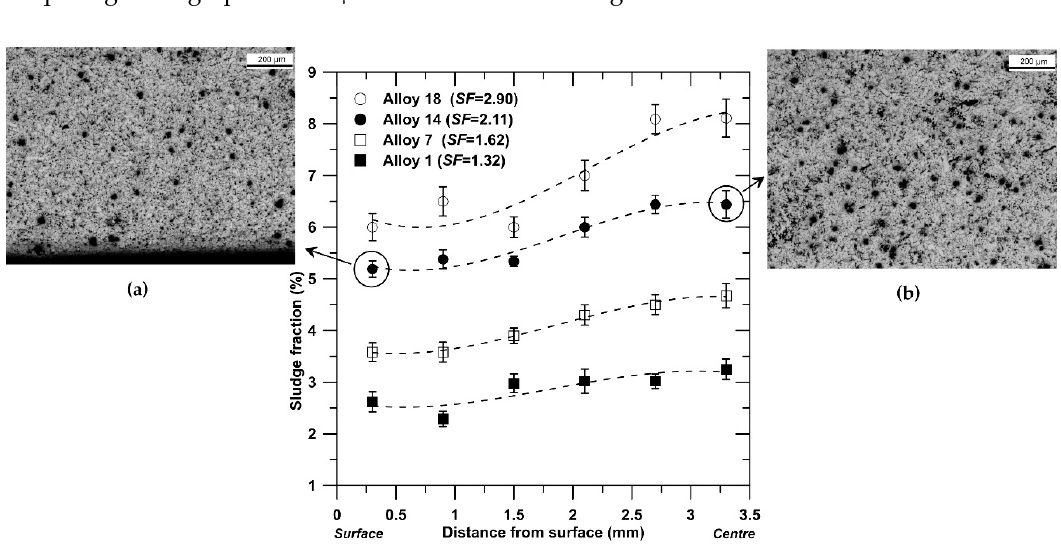
Figure 7. Evolution of the area fraction of sludge particles along the cross section of the plates die cast with different experimental alloys, here indicated with their sludge factor (SF), which was calculated according to Equation (1). The micrographs refer to ( a ) the casting surface and ( b ) the center of the plate (Alloy 14); the Fe-rich particles appear dark in the etched microstructures.